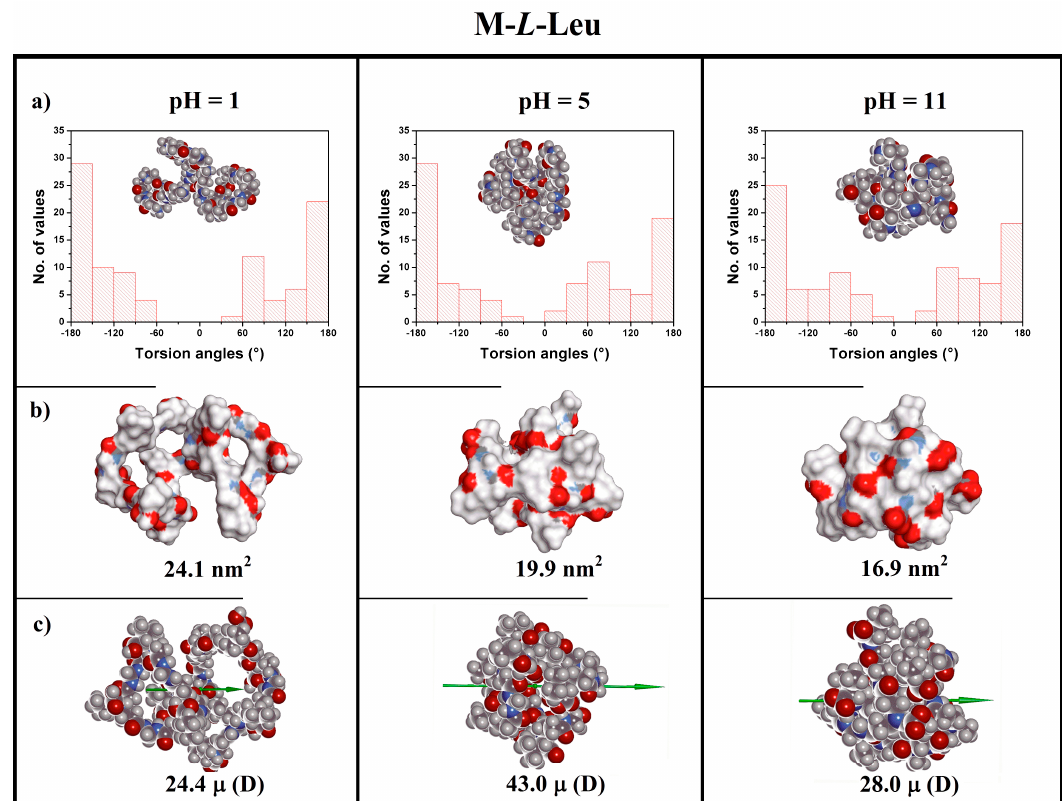
Figure 12. ( a ) Main chain molecular conformations in water at the end of the MD runs for M- L -Leu at pH 1, 5 and 11 and torsion angle distributions around the main chain bonds: the histogram are shown with a binning of 30°. Color codes: C atoms dark grey; H atoms light gray; N atoms blue; O atoms red. ( b ) Solvent accessible surface area in water. The surface area is in dark grey near C atoms, in light gray near H atoms, in blue near N atoms and in red near O atoms. ( c ) Dipole moments in water. Color codes are the same as in row ( a ).